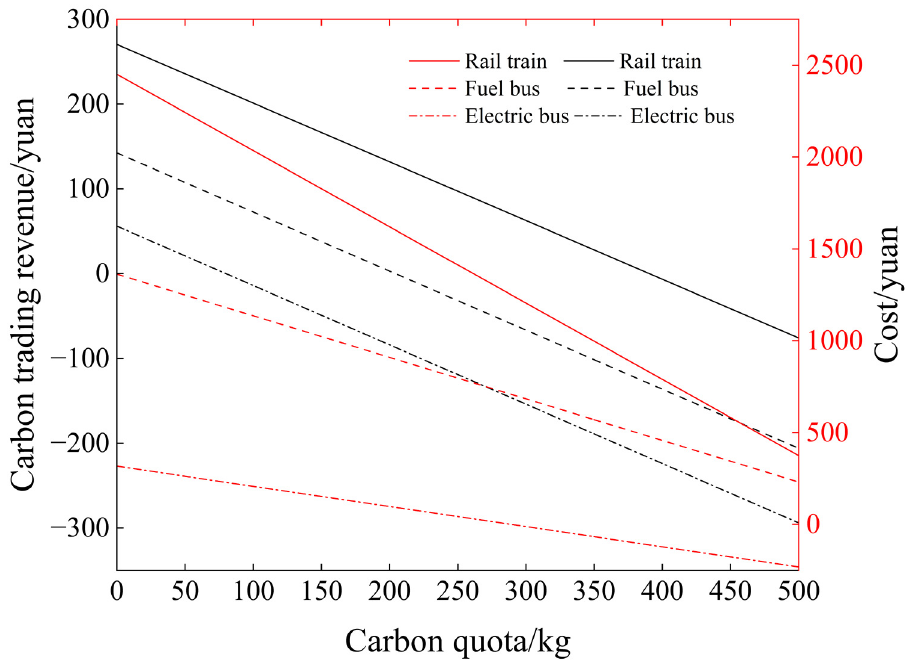
Figure 6. Change in carbon transaction cost and total cost of urban public transport vehicles under different carbon quotas.